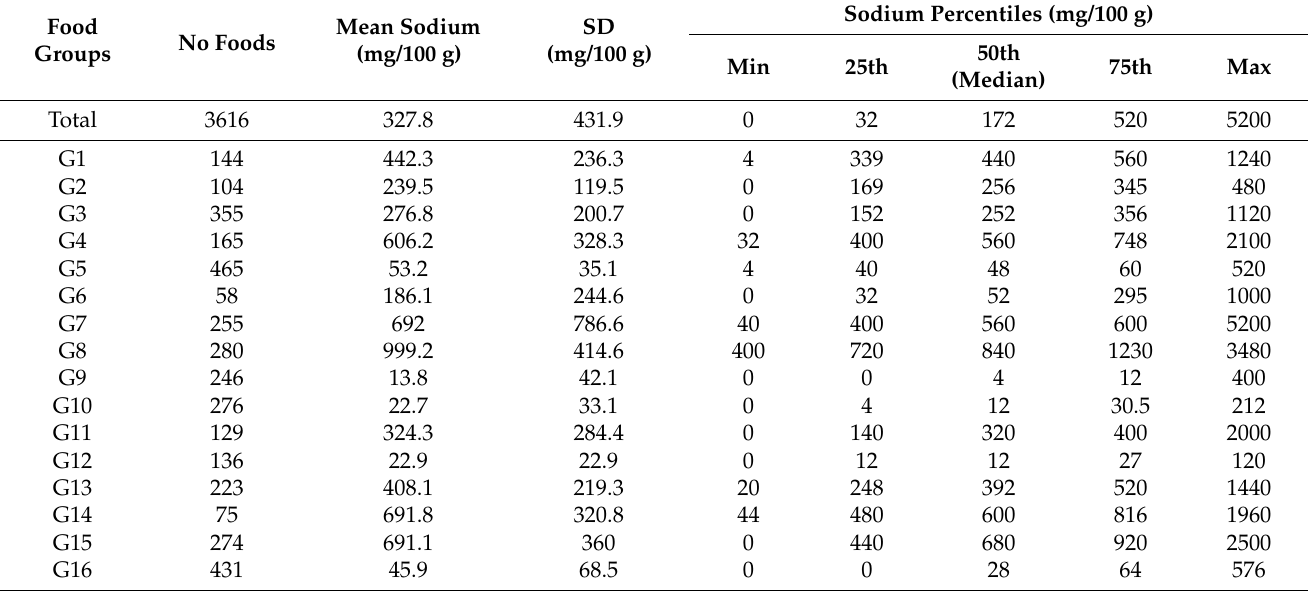
Table 3. Sodium content by food